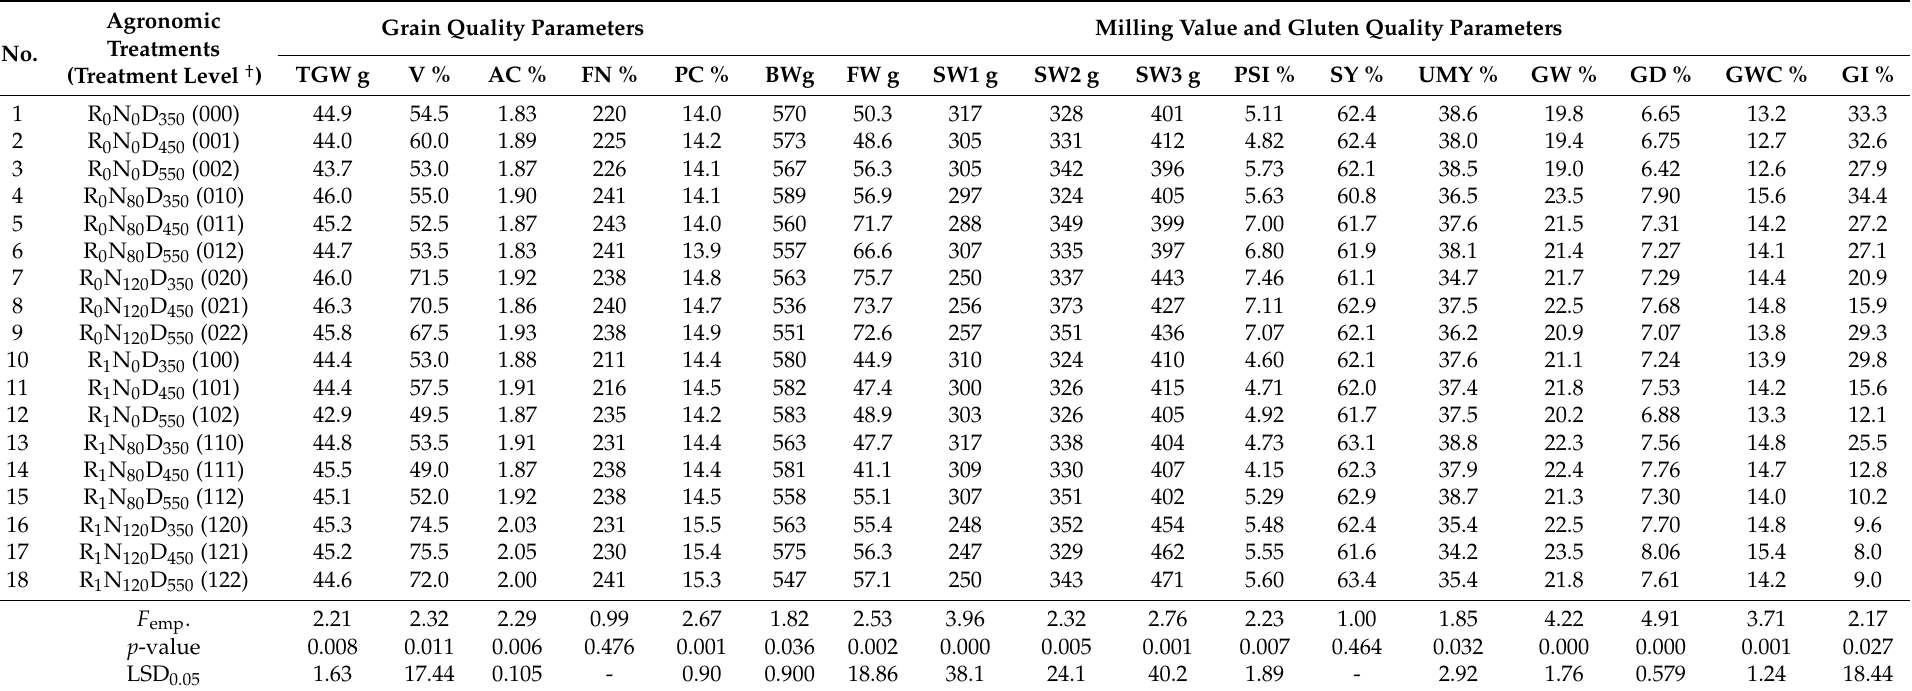
Table 2. Variability in the mean values of grain quality and milling value parameters across agronomic